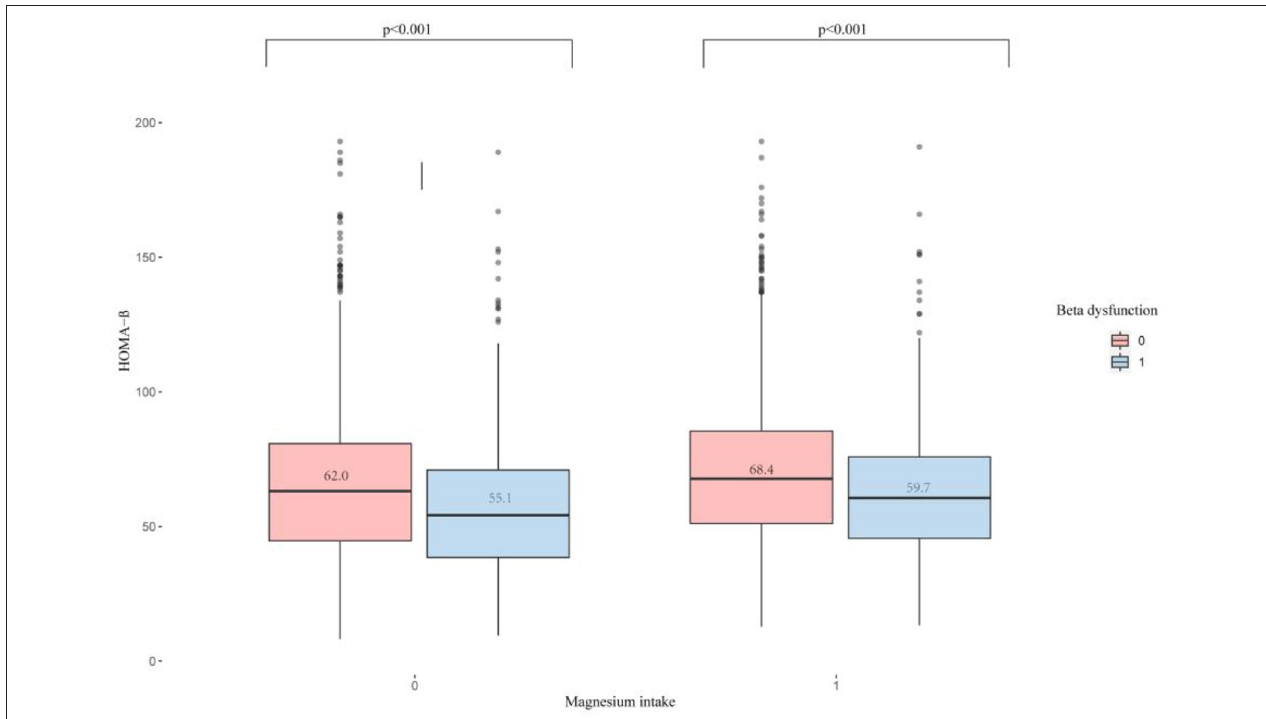
FIGURE 3 | Distribution of serum Vitamin D in pancreatic β -cell dysfunction grouped by Magnesium intake. 0, IR-positive; 1, IR-negative; p <